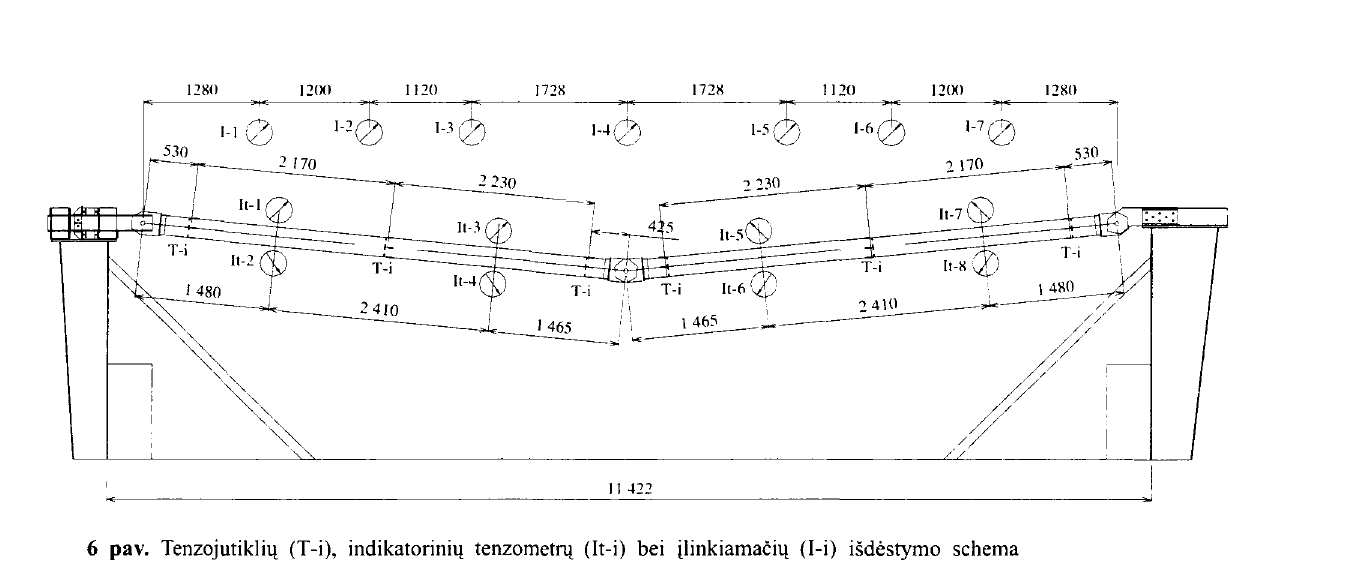
ties (C0 2) dujq aplinkoje. Kitos jungiamosios detales buvo privirintos rankiniu biidu 342 markes elektrodais.